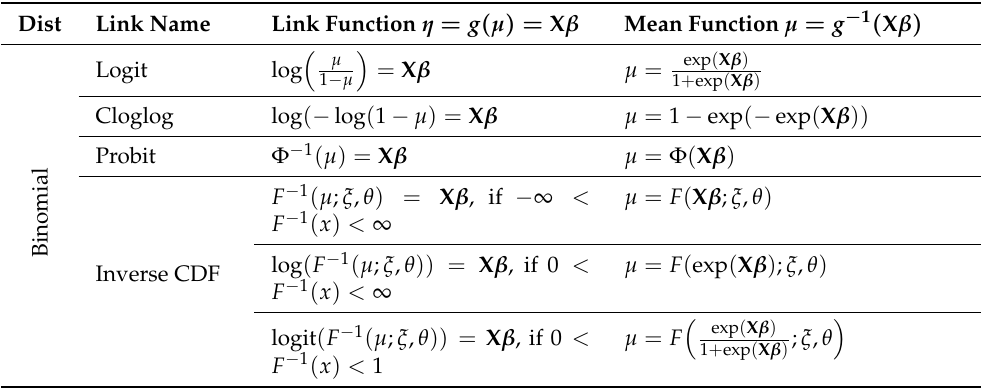
Table 1 summarises the transformations of the HS model along with key characteristics. Table 1. Link functions transformations of the HS